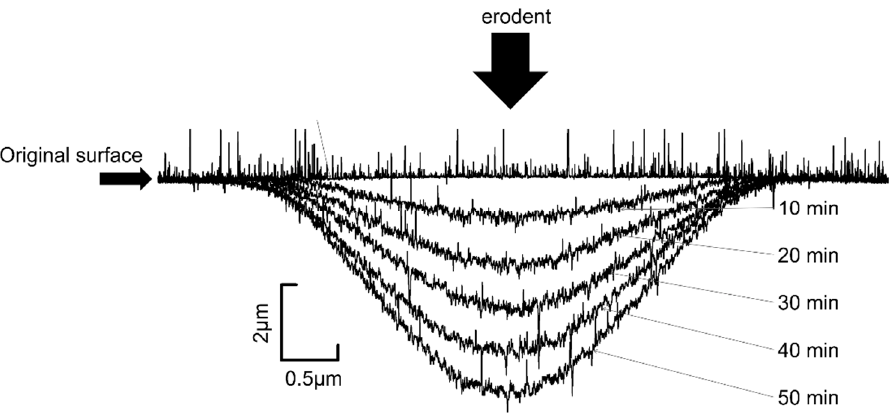
Figure 3. Typical surface profile change in sample during the MSE test. (coating: Ti 0 . 53 Al 0 . 47 N).